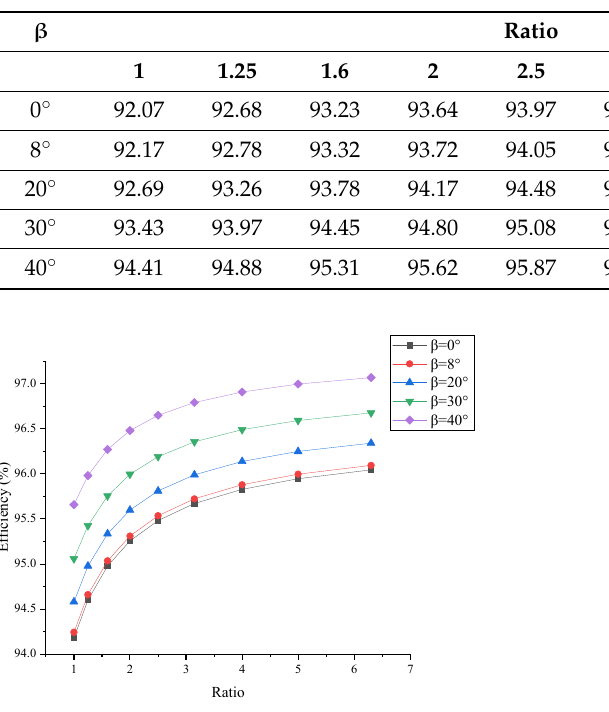
Table 6. Lookup table for gear ratio and efficiency (without lubrication). Table 5. Lookup table for gear ratio and efficiency (with lubrication).